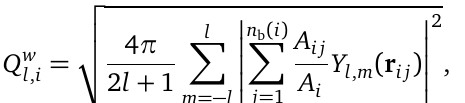
Figure 4: (a, b): Bond orientational order parameter Q w a function of their volume fraction (a), or the volume fraction of the parent fluid, φ (c, d): Similar plots for the fraction of icosahedral structures characterized by the ( 0,0,12 ) Voronoi signature. The vertical lines are a guide for the